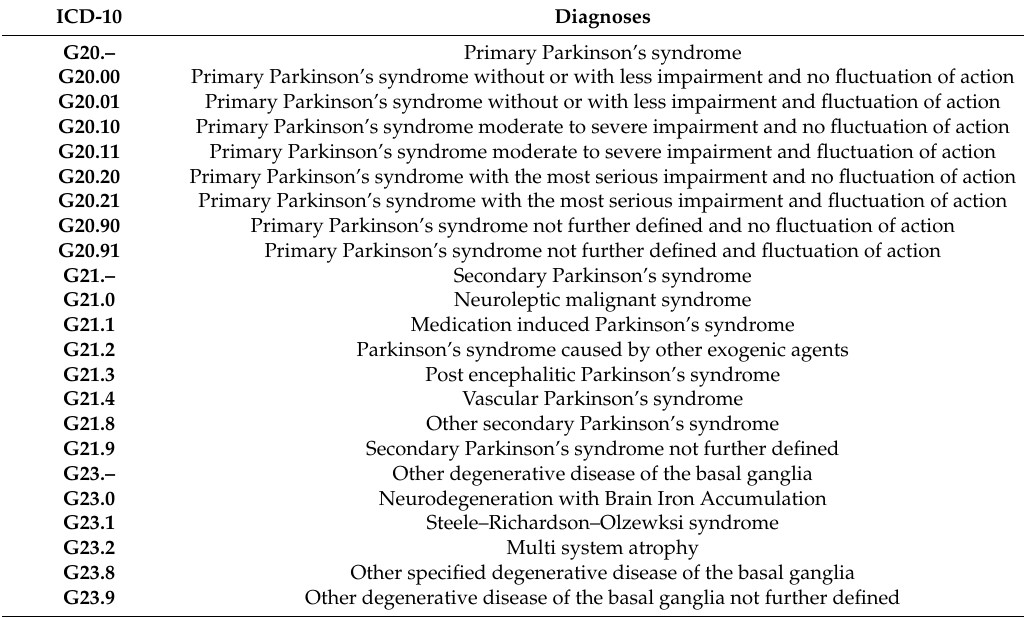
Table 1. Parkinson diagnoses and corresponding code of the International Statistical Classification of Diseases and Related Health Problems 10th revision, German modification (ICD-10-GM).